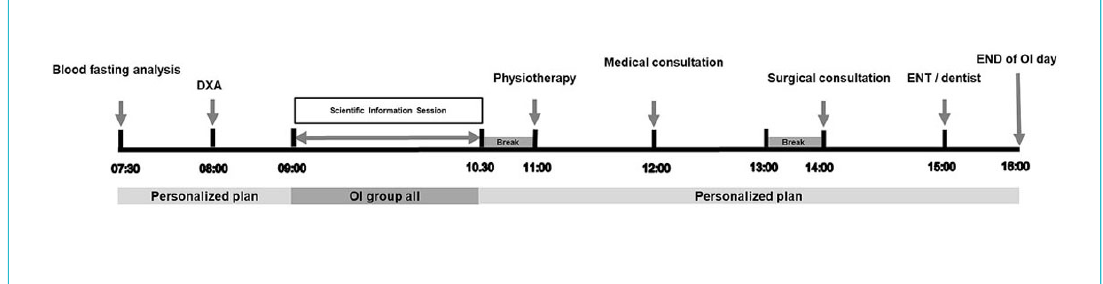
Figure S1: Timeline of an OI day, example for one patient. DXA = dual X-ray